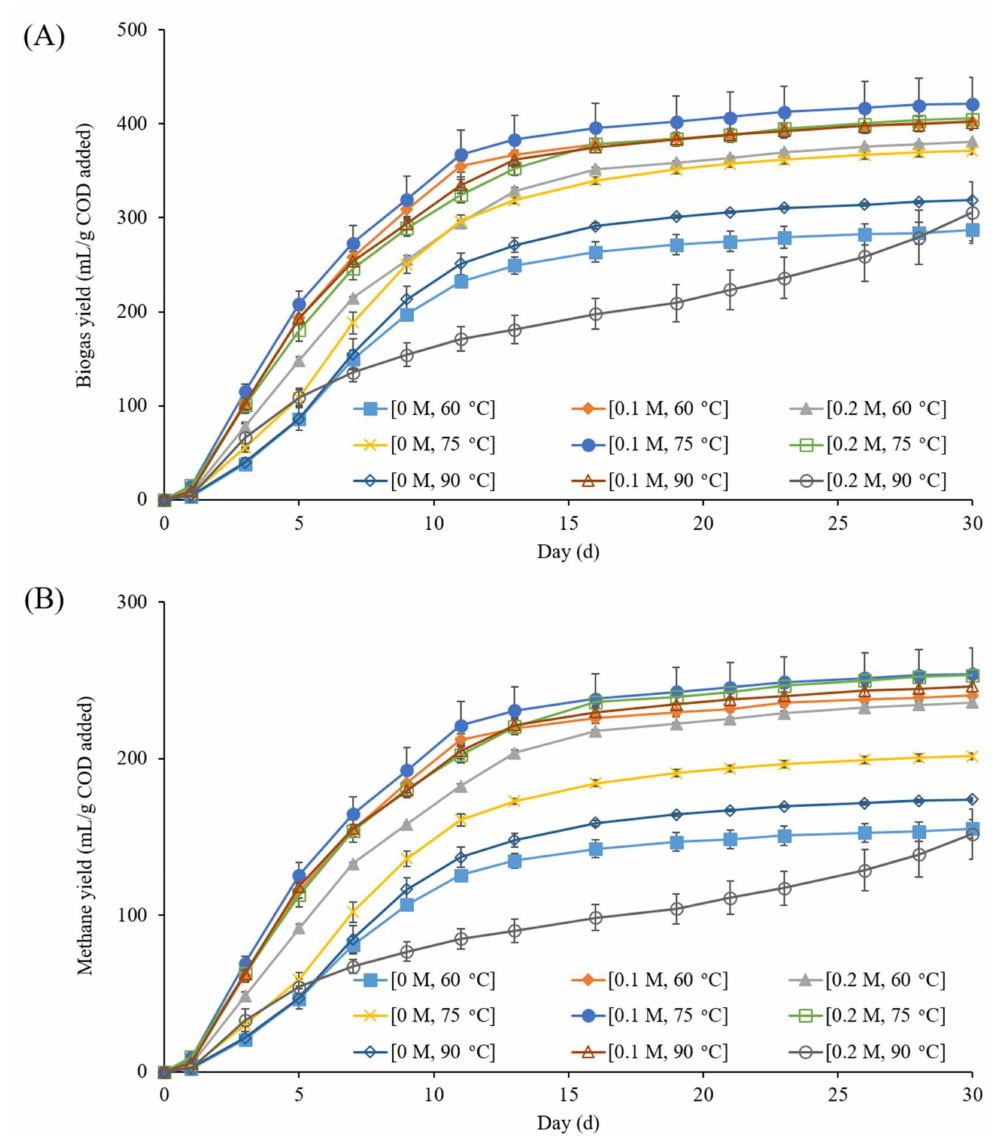
Figure 1. Cumulative biogas ( A ) and methane ( B ) production per gram of substrate COD added in the BMP runs with pretreated SCG. Each curve is labeled with the corresponding pretreatment conditions, i.e., NaOH concentration (M) and temperature ( ◦